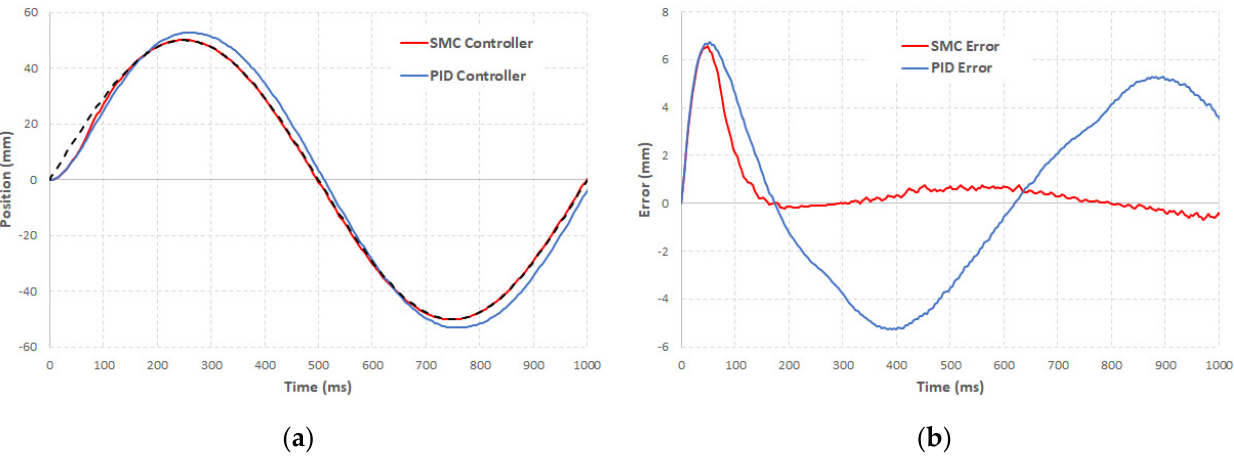
Figure 6. Control performances of the SMC and PID controllers in 1.0 Hz sinusoidal tracking: ( a ) comparison of desired (black dashed line) and measured trajectories; ( b ) tracking errors.